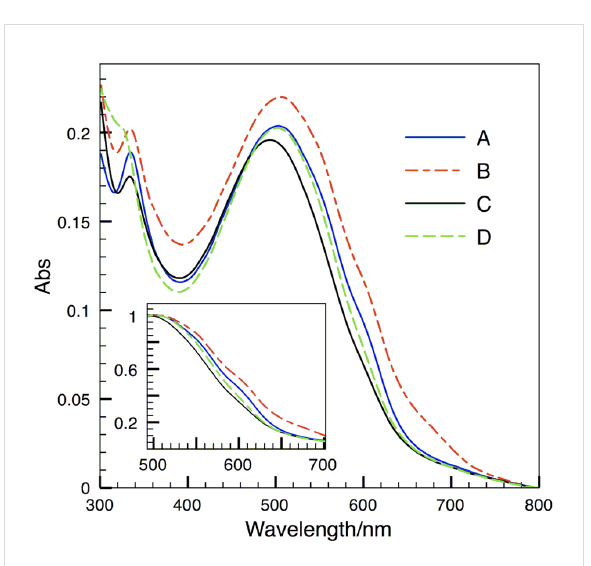
Figure 3: UV-Vis absorption spectra of P3HT/fullerene blend films for (A) PCBM, (B) ThCBM, (C) 2-BThCBM ( 3a ), and (D) es-TThCBM ( 3d ). Inset: normalized spectra at 500